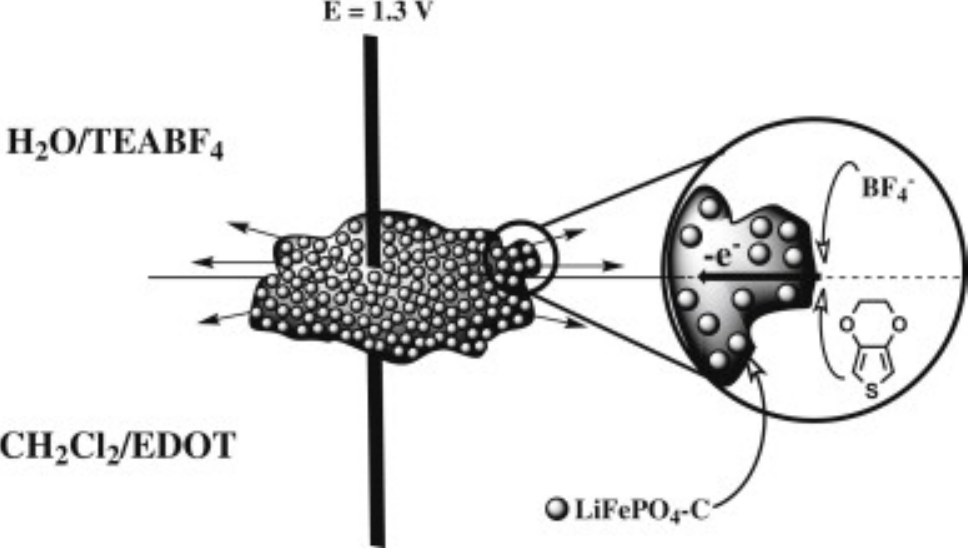
Figure 7. Schema of the D3PIE method in dynamic growth with LiFePO 4 at the wa- ter/dichloromethane interface [89]. Reprint with permission from [89]; Copyright 2013,